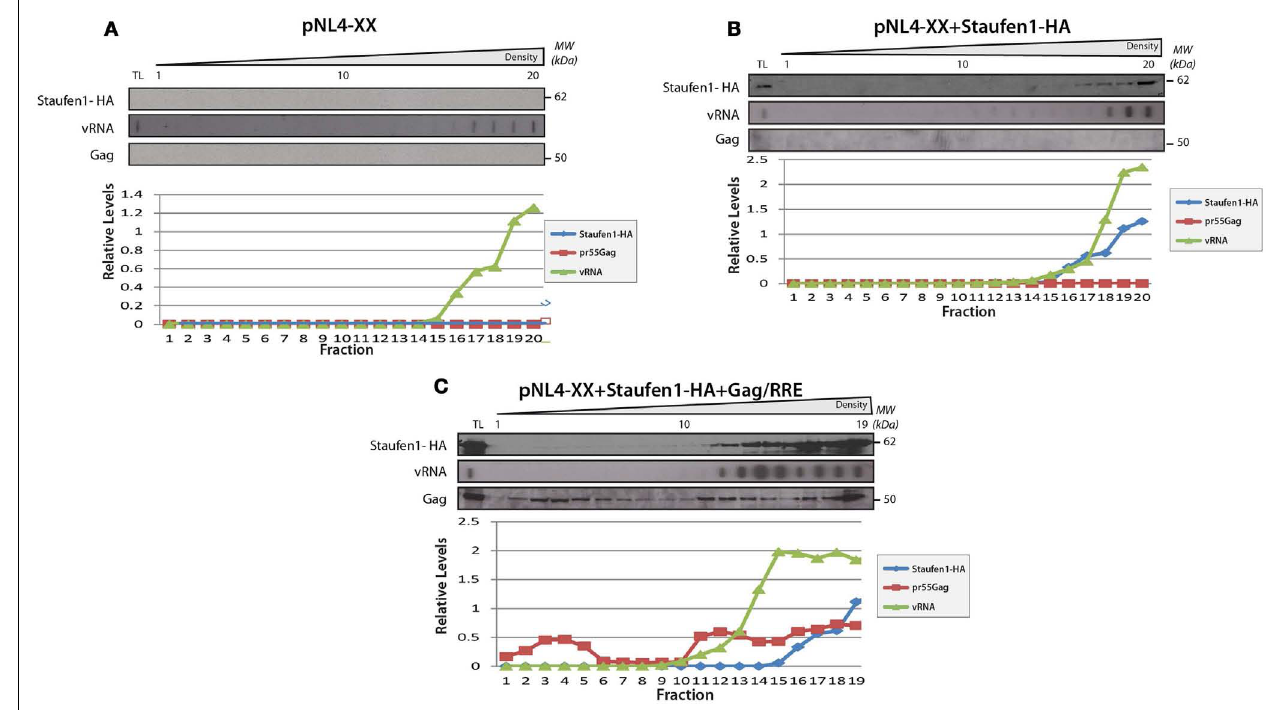
lysates were then fractionated on 5–50% sucrose gradients and 20 fractions were collected for further analysis by western blotting analyses, as indicated. TL represents the total lysates. Staufen1, Gag and vRNA were quantitated in each fraction by densitometry and relative levels are depicted for each fraction (Blue: Staufen1-HA, Red: Gag, Green: